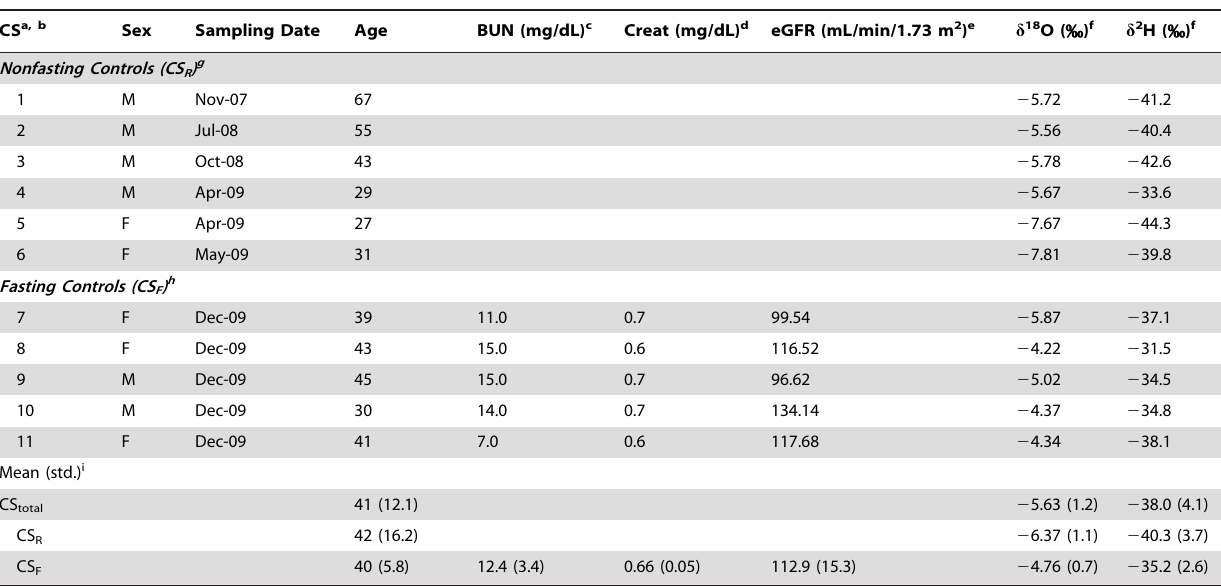
Table 1. Isotopic values of control subject’s blood